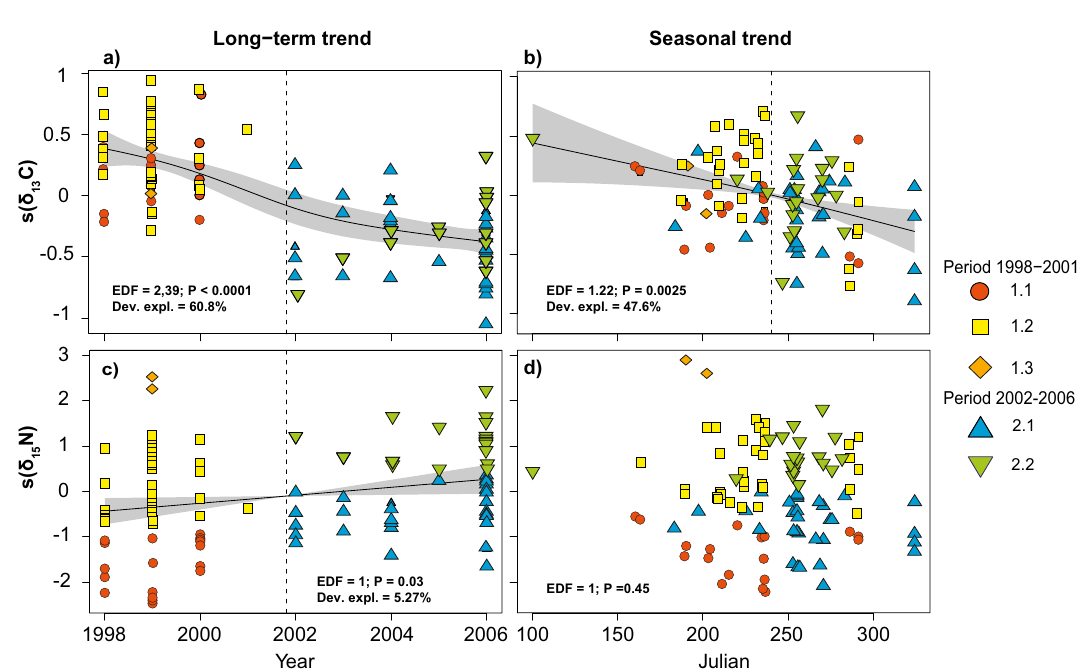
Figure 2. Long-term (a,c) and seasonal trend (b,d) in δ 13 C and δ 15 N values for fin whales sampled in the St. Lawrence Estuary between 1998 and 2006, superimposed with groups of fin whales as defined from the hierarchical cluster analysis (different symbols and colors). The y-axis shows deviations from mean isotopic values; shaded areas represent the 95% credibility interval around the generalized additive model; the dotted line represents the time of observed